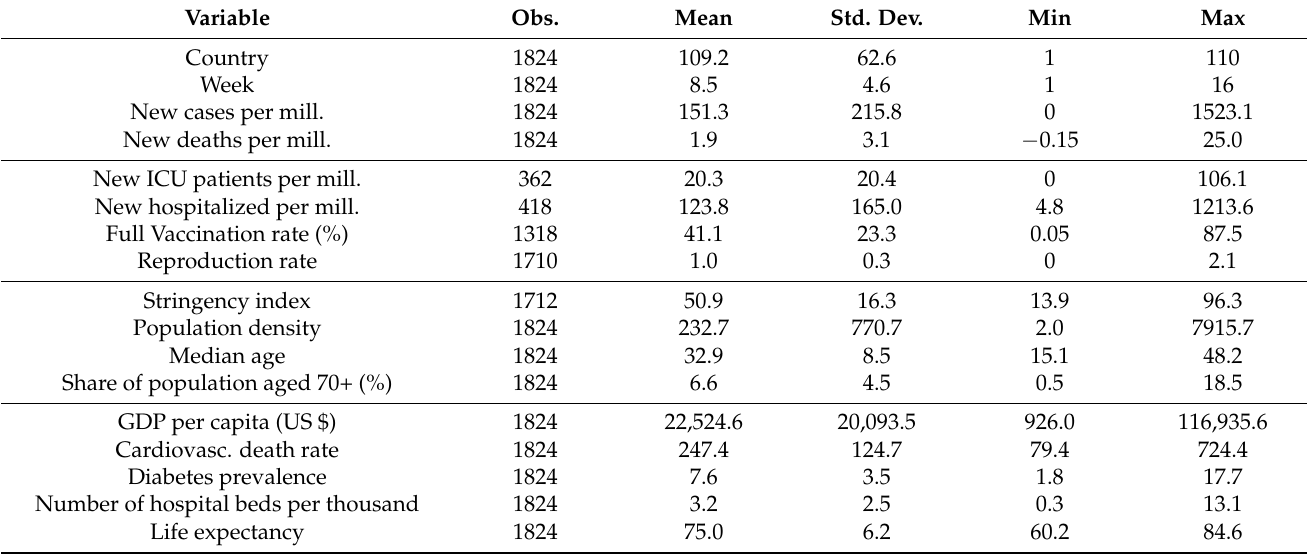
Table A1. Summary